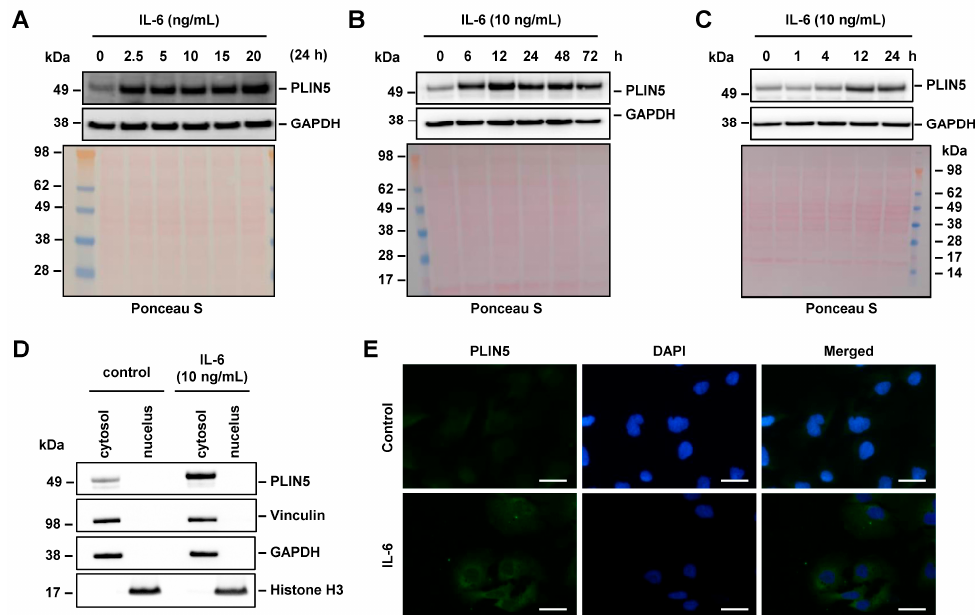
Figure 3. IL-6-mediated PLIN5 upregulation is dose- and time-dependent. ( A ) Hep3B cells were stimulated with rising IL-6 concentrations for 24 h and the cell extract probed for PLIN5 expression. ( B , C ) Hep3B cells were stimulated with IL-6 for the indicated time intervals and analyzed for expression of PLIN5 by Western blot analysis. ( D ) Western blot analysis depicting cytoplasmatic localization of PLIN5. For nuclear extraction, Histone H3 was used as control for the nuclear fraction, while the expression of Vinculin served as a marker for the cytoplasmic protein fraction. For all Western blots, GAPDH detection and Ponceau S staining served as controls to demonstrate equal protein loading. ( E ) Immunofluorescent staining of PLIN5 protein in Hep3B cell line after 24 h of IL-6 (10 ng/mL) stimulation confirmed cytoplasmic localization. Space bars represent 25 µm.